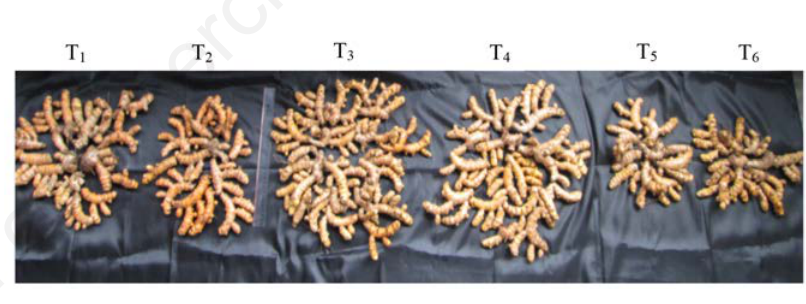
Figure 1. A) Row Relay Curcuma 12 WAP (weeks after planting) and Soybean WAP, B) Row Relay Soybean 12 WAP (weeks after planting) and Curcuma 8 WAP (B).